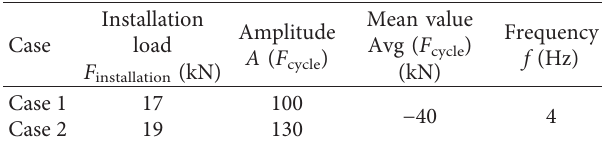
Figure 7: Measured wheel-rail forces and corresponding equivalent sinusoidal loads in the FE calculations. (a) Case 1. (b) Case 2. Table 2: Parameters related to installation loads and cycle loads in the FEA.